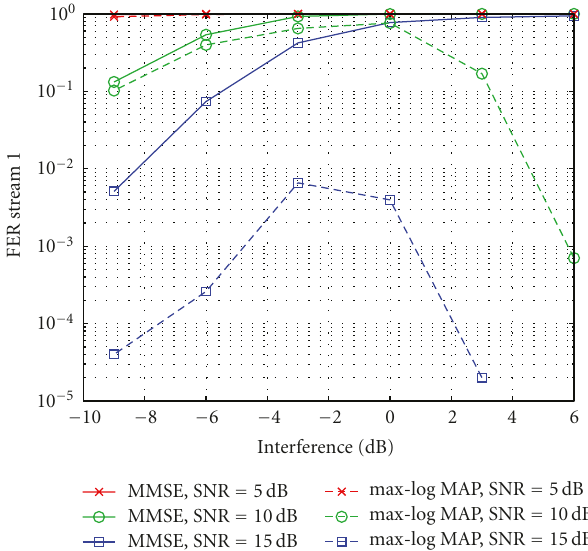
Figure 11: Frame error rate of the first stream of the of the MMSE and max-log MAP receiver for a frequency selective Ricean fading channel with a K-factor of K = 10. Results are plotted for di ff erent SNR levels of the first stream. The x -axis denotes the interference of the second stream w.r.t. the first